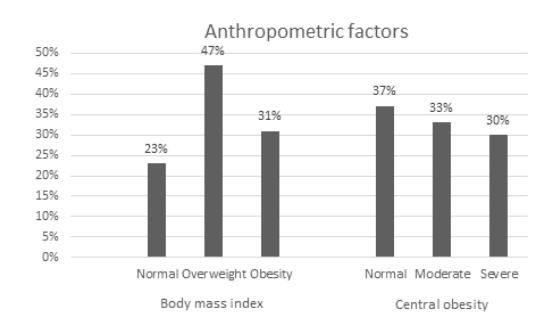
Figure 4. Distribution of the anthropometric factors in physicians.